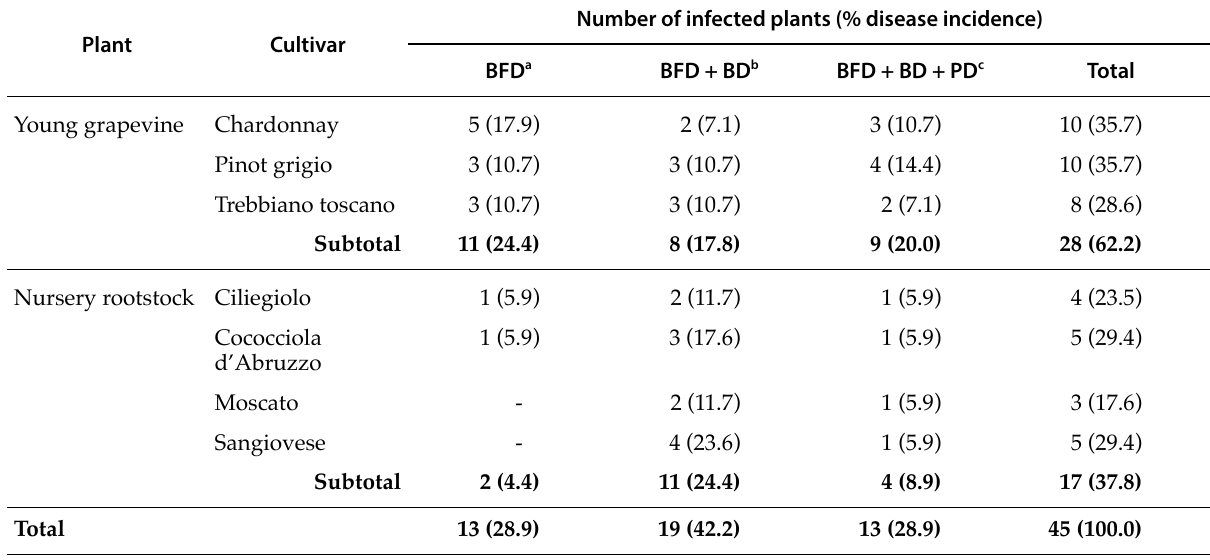
Table 4. Grapevine samples affected by fungal diseases associated with vineyards, based on the fungal species isolated.